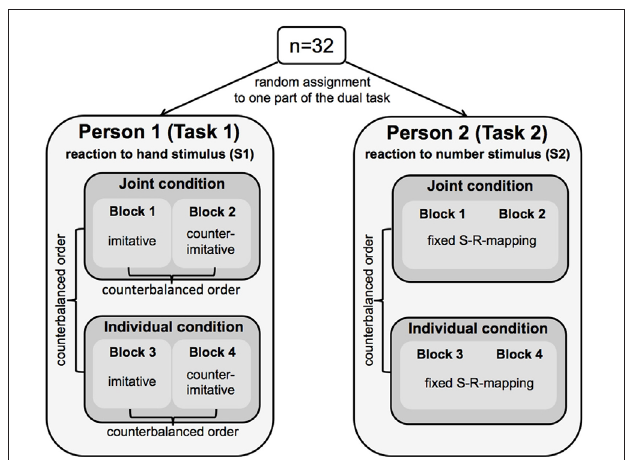
FIGURE 2 | Schematic illustration of the experimental design used in the present study. Thirty-two participants were randomly assigned to one part of a dual-task. Person 1 (Task 1) responded to finger-lifting movements of a hand stimulus (S1) either in an imitative or counter- imitative way, the order of which was counterbalanced block wise across participants. Person 2 (Task 2) responded to a number stimulus (S2) presented between the moving fingers of the hand stimulus. Person 2 always responded with a fixed S(timulus)-R(esponse) mapping by lifting the index finger for digit 1 and lifting the middle finger for digit 2. Both tasks were performed in a joint and in an individual condition. The order of conditions was also counterbalanced across